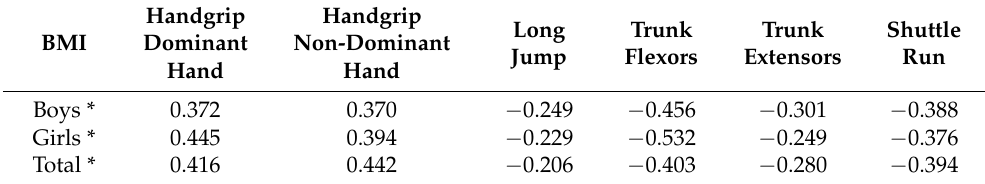
Table 3. Spearman correlations ( p -values) between BMI and physical performance test.